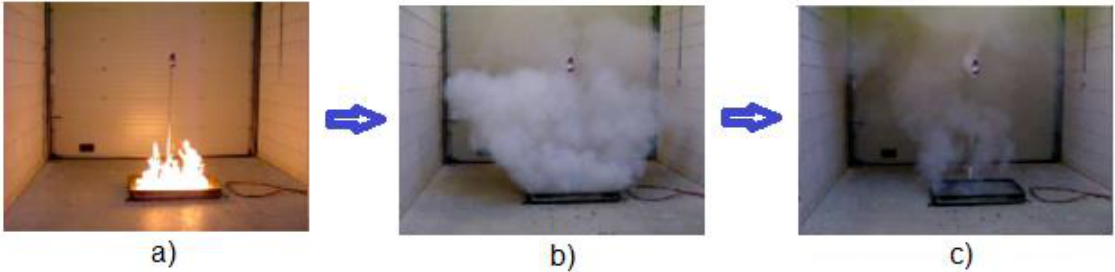
Figure 3. Test fire extinguishing ( a ) and aerosol visibility at 5 ( b ) and 15 s ( c ) after fire extinguishment in the test chamber.